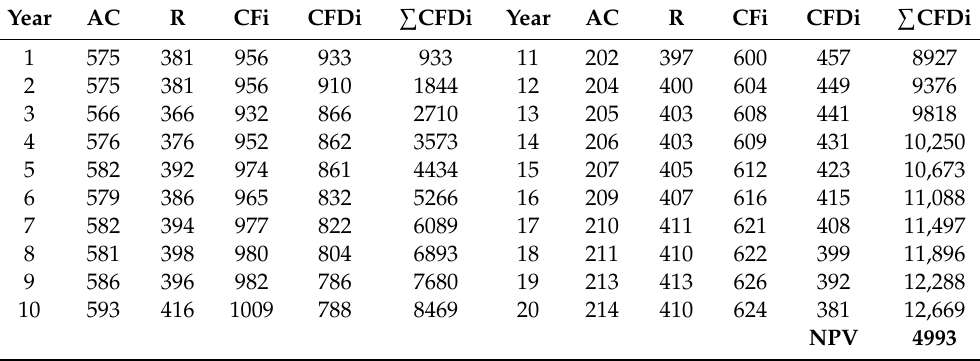
Table 15. Cash-Flow Analysis—Location 2, PV plant without Battery (cost investment, C 0 = 7676 €